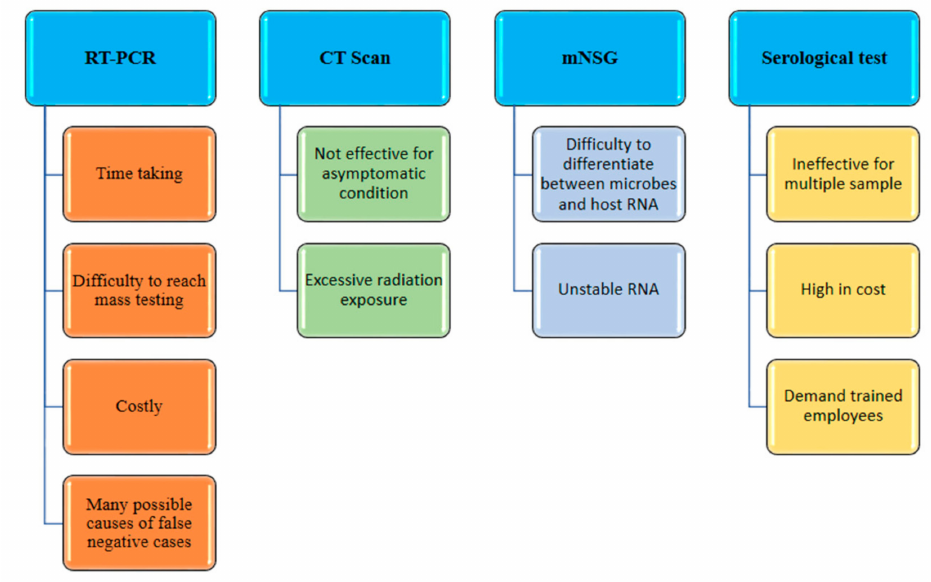
Figure 1. Disadvantages of traditional